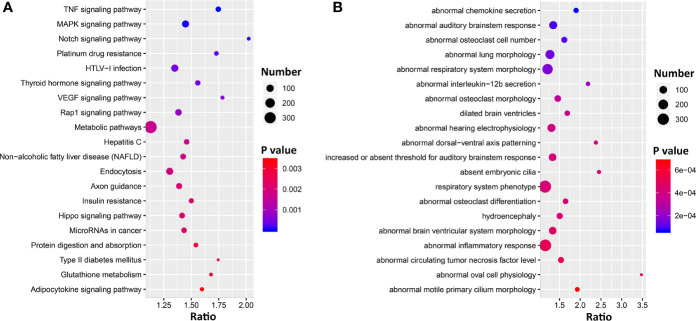
Bubble charts of the top 20 KEGG pathways (A) and 20 Mammalian Phenotype Ontologies (B) enriched for Ace2 significantly correlated genes. Gene over-representation analysis for KEGG pathway and Mammalian Phenotype Ontology of the Ace2 correlated transcripts (p < 0.05) were performed with WebGestalt (www.webgestalt.org). The x-axis represents the enrich ratio and the y-axis represents enriched pathways/terms. The size of the dots denotes the number of genes and the color denotes the p-value.